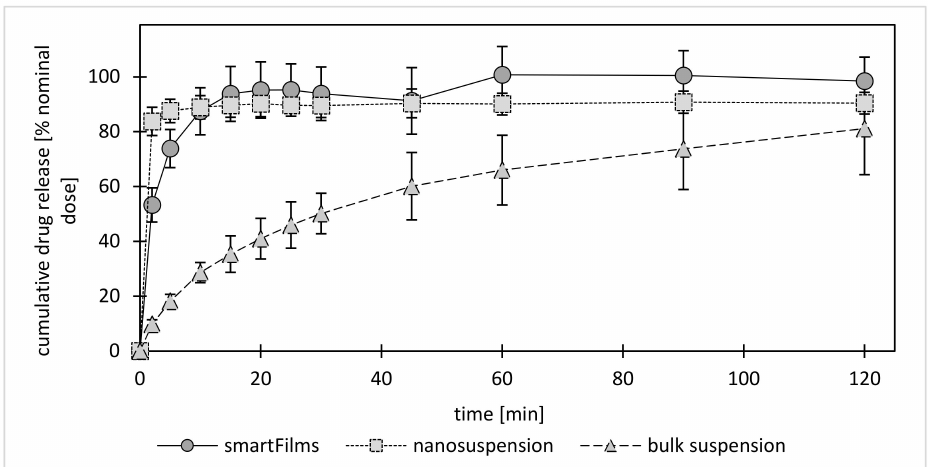
Figure 3. Dissolution profiles of curcumin from smartFilms and benchmark controls (curcumin bulk suspension and nanosuspension—explanations—c.f.